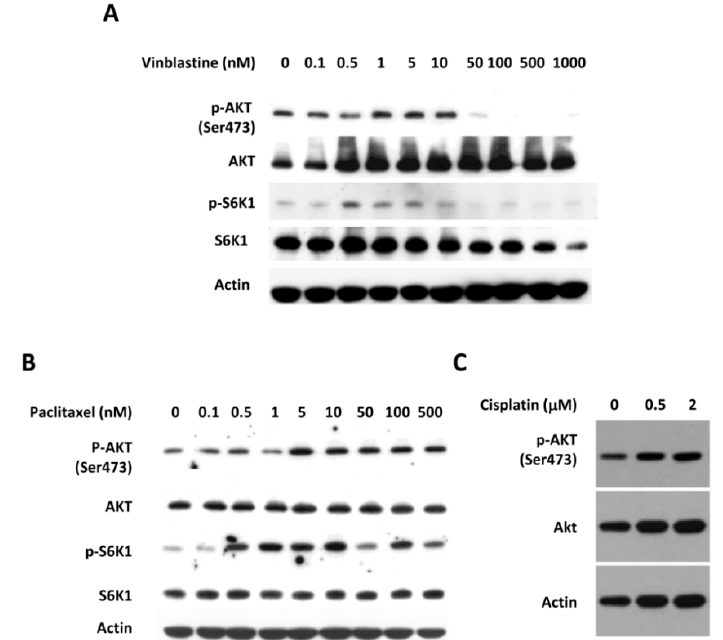
Figure 2. The effect of commonly used cytotoxic agents on AKT phosphorylation. MDA-MB-468 cells were treated with vinblastine ( A ), paclitaxel ( B ), and cisplatin ( C ) at indicated concentrations. Cells were harvested at 24 h, and the expression of p-AKT and p-S6K1 was measured by Western blot analysis.